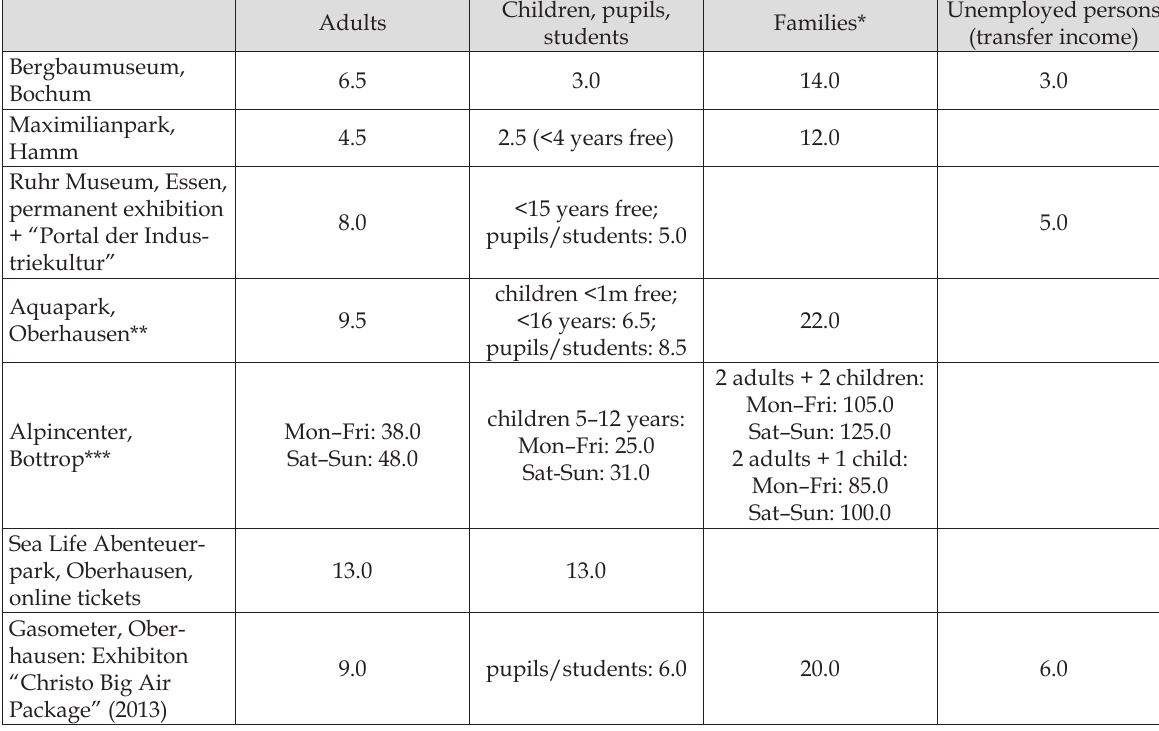
Table 1. Entrance fees to selected recreational areas in the Ruhr area (in